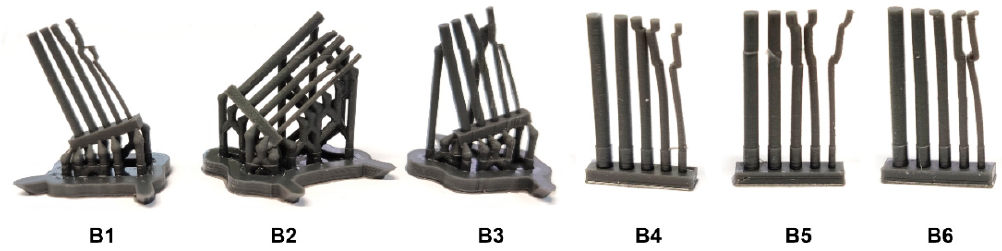
Figure 7. Additive manufactured single bars with varying diameter on common base with varying support structure, tilting angle and orientation on the building platform (rotation in z-axis).